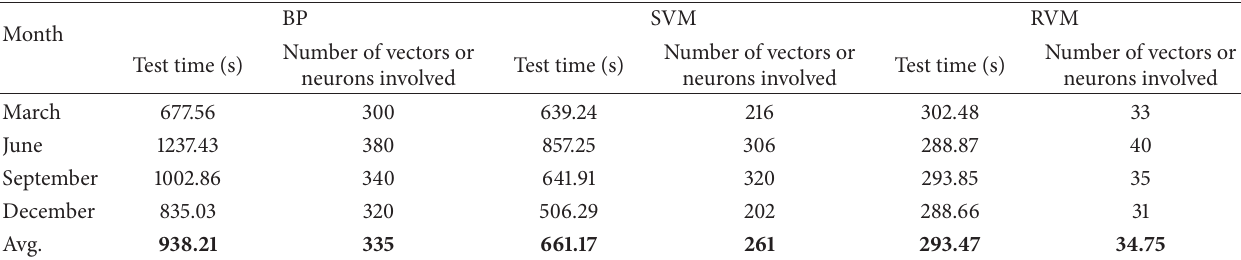
Table 2: Comparisons of test time and vector number for three